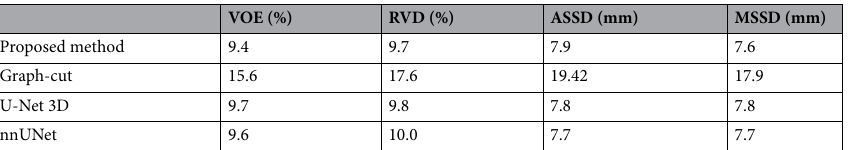
Table 4. Mean values of segmentation evaluation error metrics: VOE, RVD, ASSD and MSSD based on CT images for renal detection.